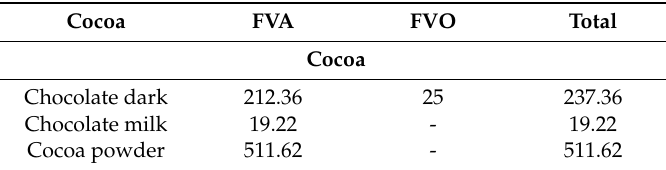
Table 5. Flavonoid contents of cocoa (mg / 100 g food) [24].